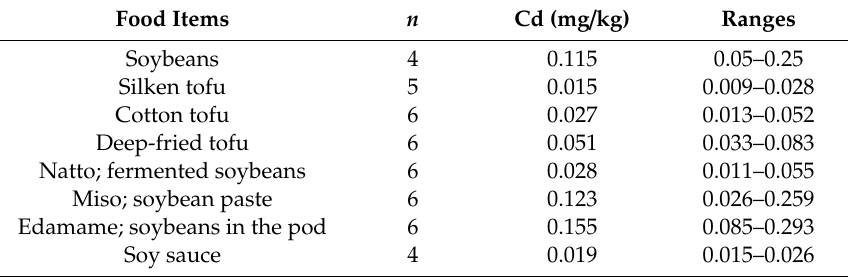
Table 3. Cadmium (Cd) concentrations in soybeans and soybean products. Data are presented as arithmetic means.